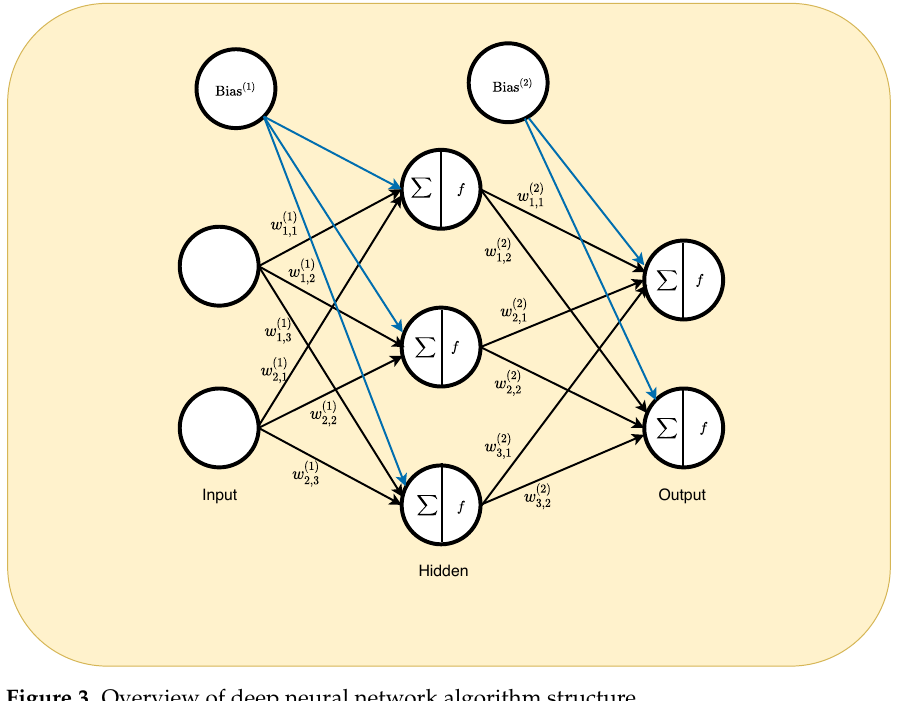
Figure 3. Overview of deep neural network algorithm